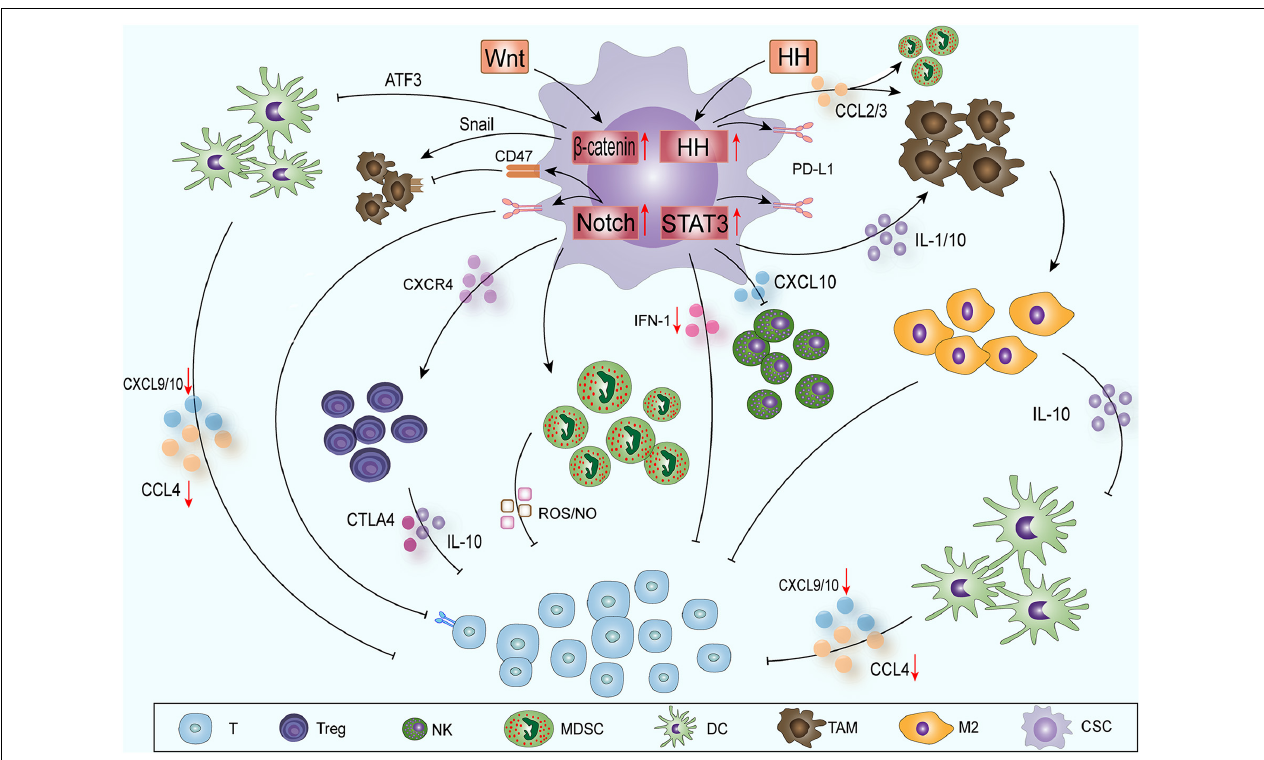
FIGURE 1 | CSCs create ITAIMs mainly through four SRSs: The Notch-NF- κ B axis, HH, Wnt and STAT3 pathways. Exogenous Wnt and HH proteins enter CSCs to activate corresponding SRSs. Wnt signaling acts on CD103 + DCs by inducing the transcription inhibitor ATF3. The reduction in CCL4, CXCL-9 and -10 reduces CD8 + T cell activation and infiltration. HH signaling recruits TAMs and immunosuppresses MDSCs by releasing CCL2 and CCL3. Notch-NF- κ B axis signaling mainly regulates Tregs, MDSCs and T cells through a series of cytokines in the TAIM. Activated STAT3 signaling can promote the accumulation of immunosuppressive CD163 + TAMs through IL-1 and IL-10. It also downregulates the expression of CXCL-10 and reduces the cytotoxicity of NK cells. The activation of STAT3 inhibits the expression of type I IFN signaling and antitumor immune responses. The HH and Notch-NF- κ B axis and STAT3 signaling pathways can also promote PD-L1 expression and suppress the immune